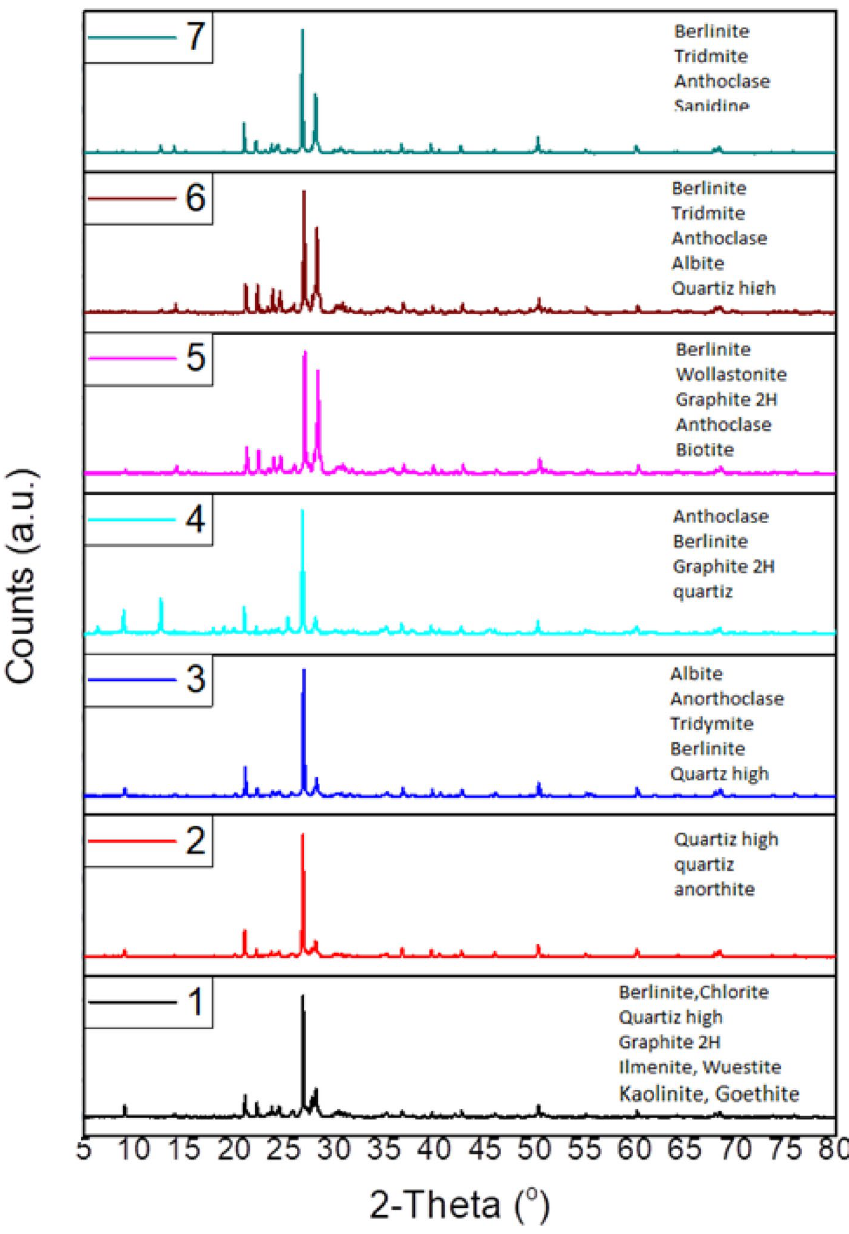
Figure 2. XRD spectra of the analyzed tuffs samples.